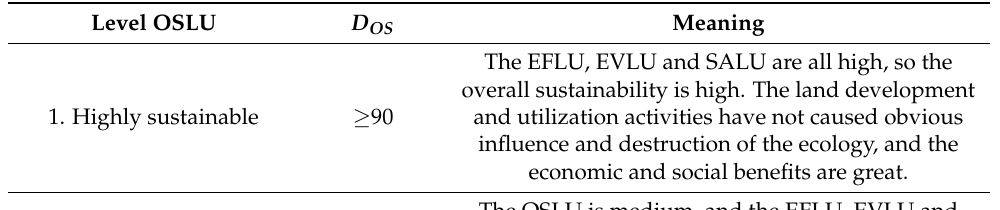
Table 6. Grading standard and basic meaning of